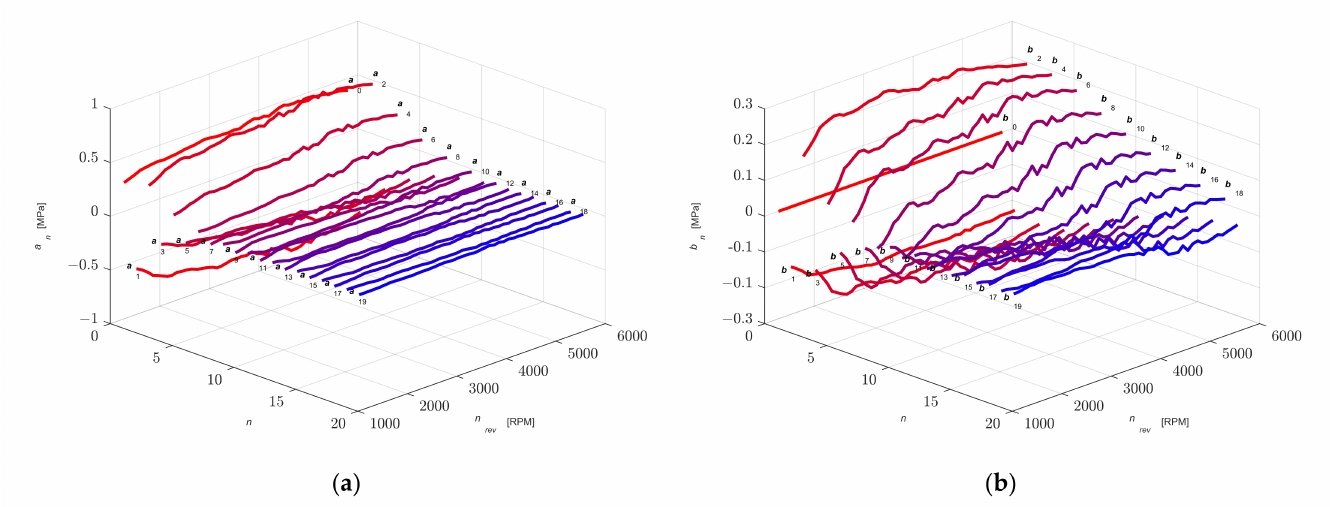
Figure 14. Determined values of coefficients a n ( a ) and b n ( b ) of a Fourier series as a function of rotational speed.